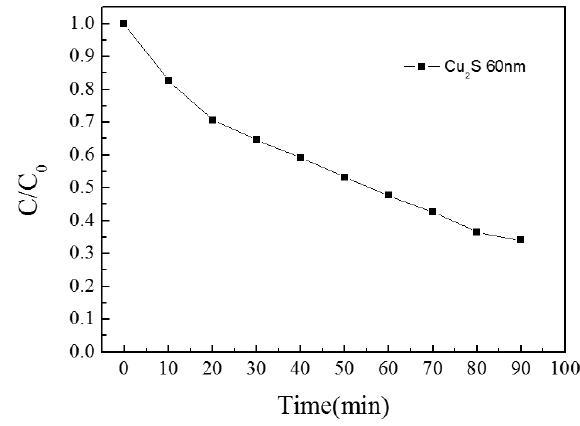
Figure 7. The photocatalytic activity of Cu 2 S/glass complex films for different thickness.